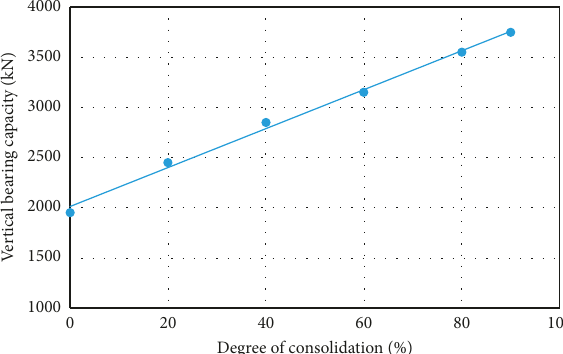
Figure 10: Relationship between vertical bearing capacity and degree of consolidation.